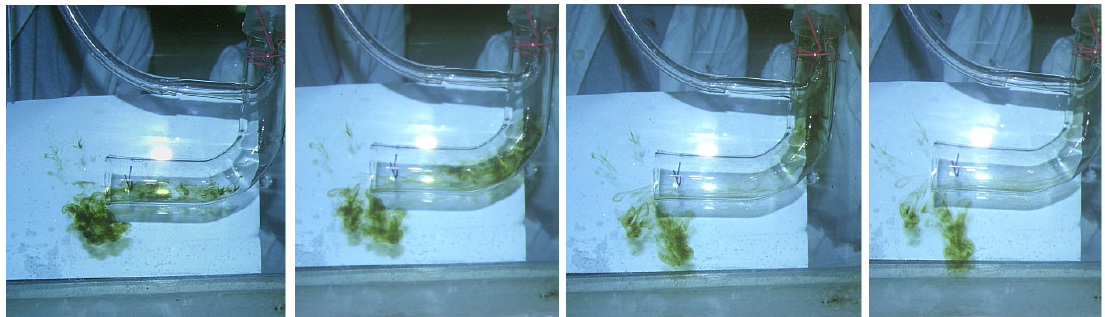
Figure 3. Turbulence test for the mini-MODUS inlet mouth. Using a pipette, a few dye drops were put just in front of the mini-MODUS entrance (water in) in order to make the water flow detectable. The influence of the water flow due to the air lift pumping was localized only very close to the mouth. The water results unaffected in the immediate proximity below the mouth. The figure shows no disturbance of the sediment at a 9 L min − 1 water flow. The time elapsed between each frame (shot from left to right) was half a second.